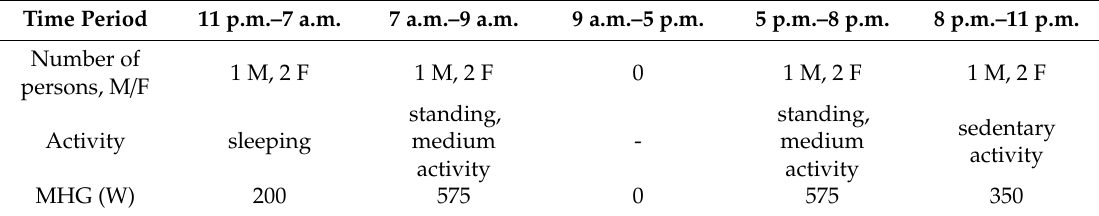
Table 5. Proposed occupancy and metabolic heat gain (MHG) profile. M and F stand for male and